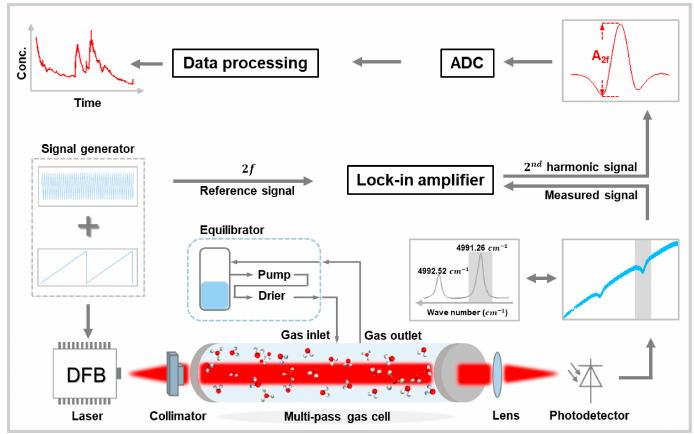
Figure 1. Schematic diagram of the optical detection part of the developed dissolved CO 2 detection system. DFB: distributed feedback laser.